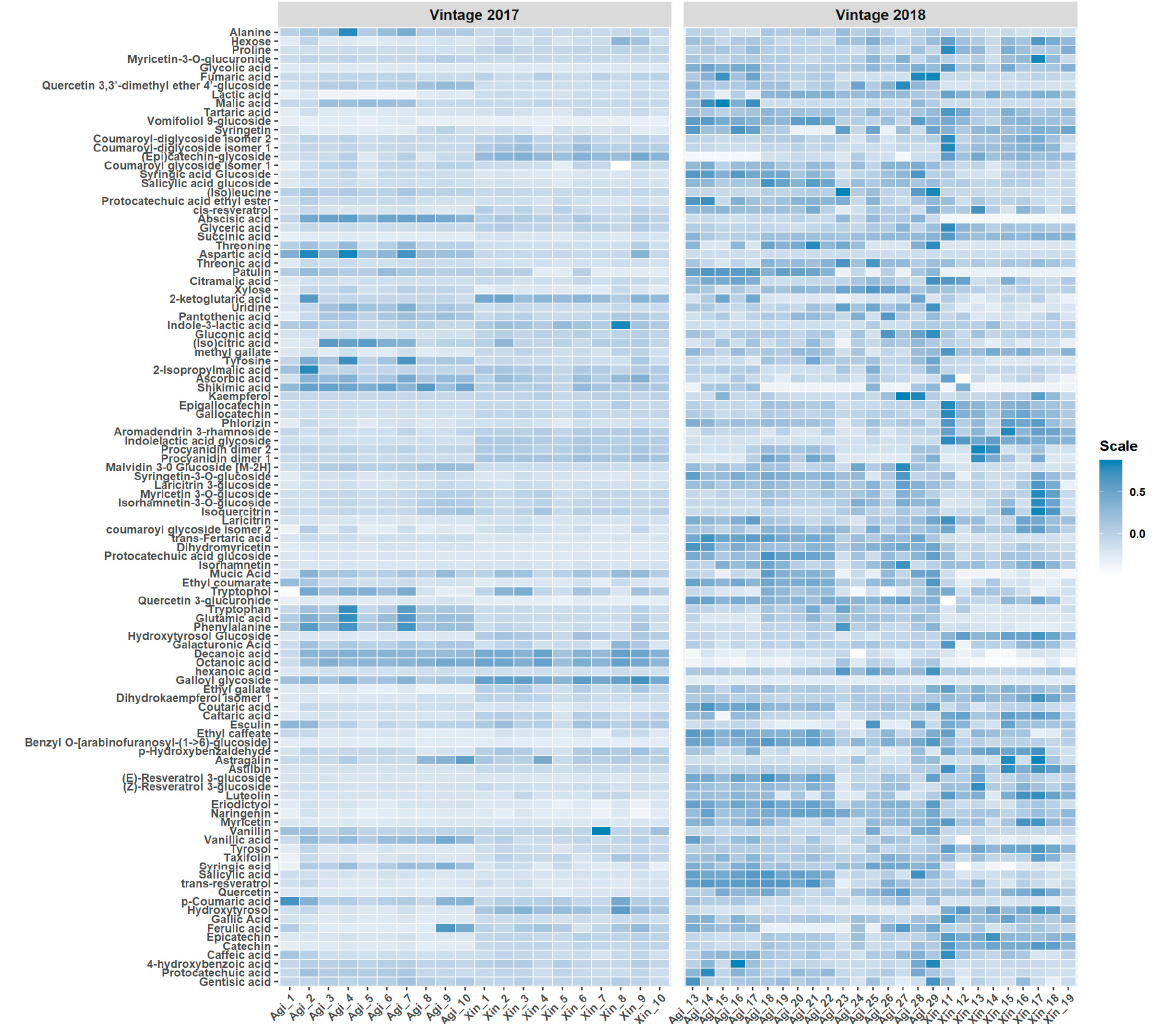
Figure 1. Heatmap of the relative abundances of target and suspect screening compounds. Samples names “Agi . . . ” and “Xin . . . ” correspond to Agiorgitiko and Xinomavro samples, respectively. Row-wise normalization (range scaling) was performed.